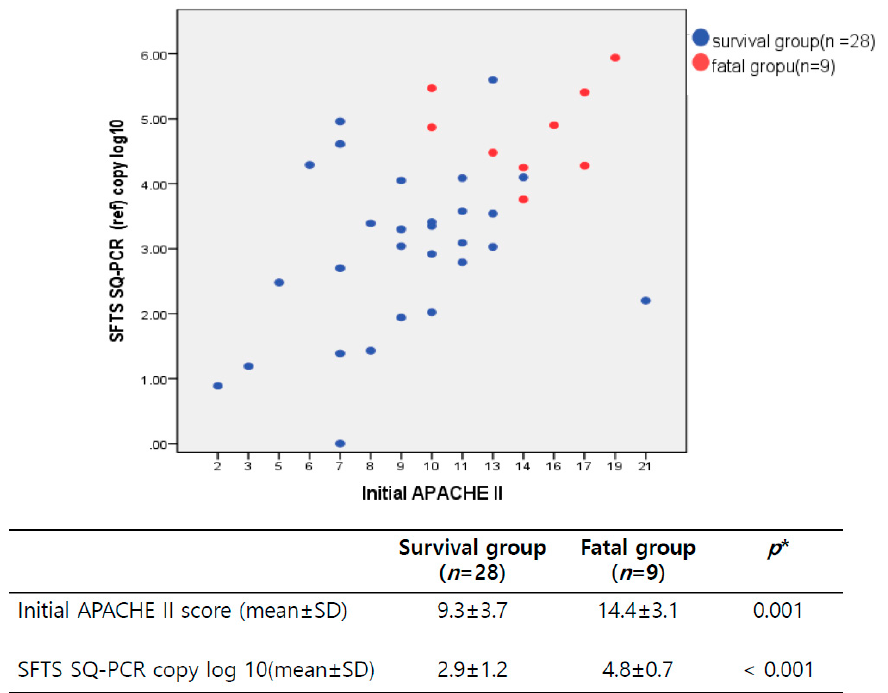
Figure 3. Correlation between the APACHE II score and the viral RNA load in SFTS patients 7 days from the symptom onset to the sample collection. from the symptom onset to the sample